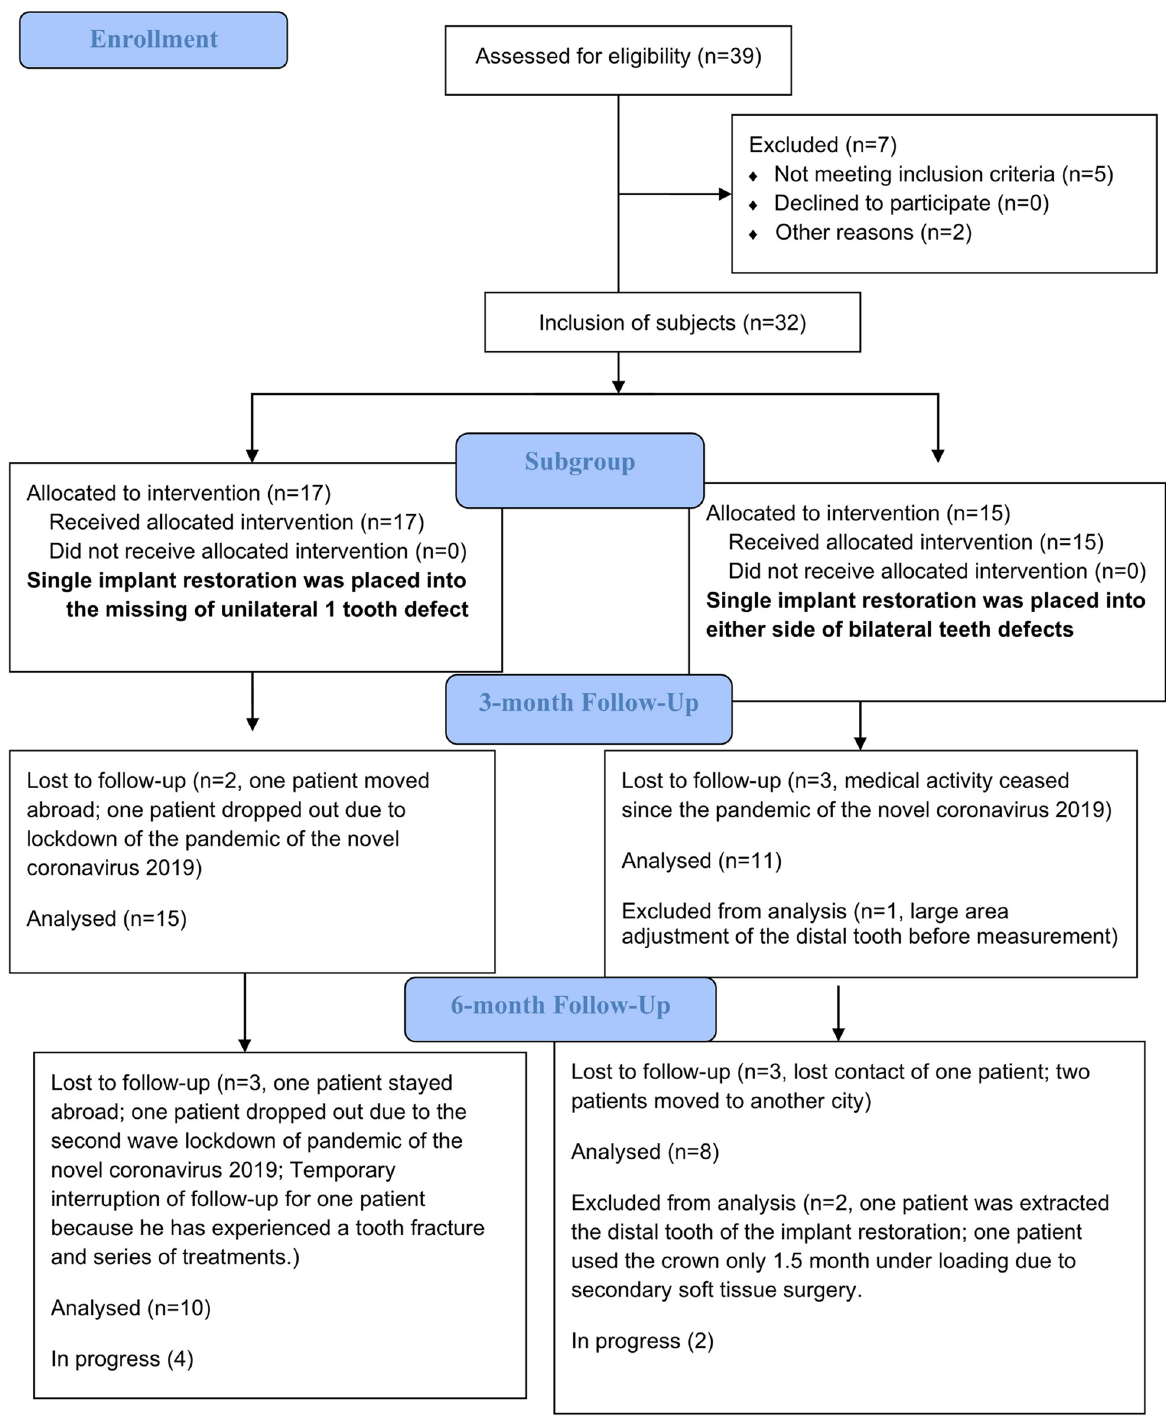
Fig 1. Research flow chart.